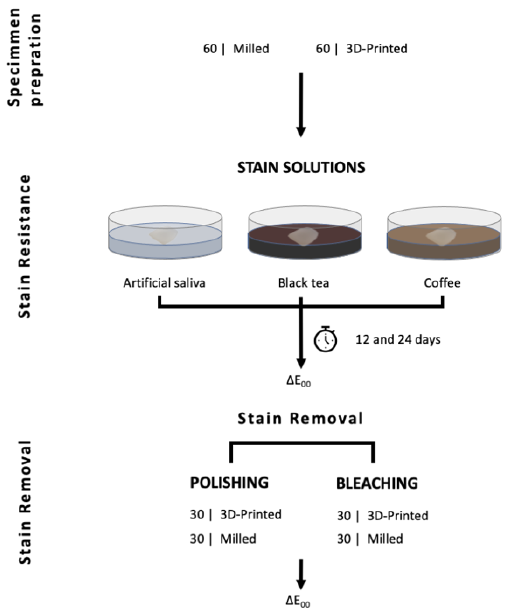
Figure 1. Experiment flowchart.